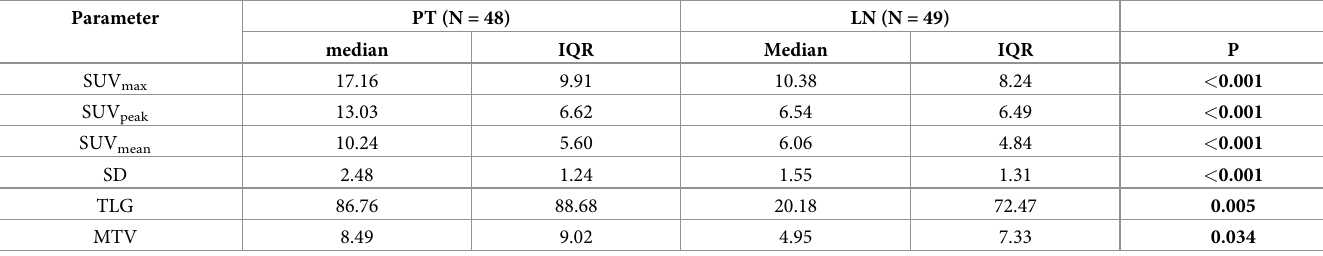
Table 3. Summary statistics of 18 F-FDG-PET parameters in primary tumors (PTs) and metastatic lymph nodes (LNs).